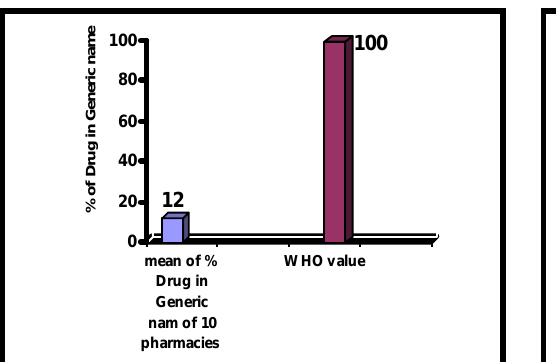
Figure 4: Comparison of the mean of percent CS/Rx of 10 pharmacies with WHO standard